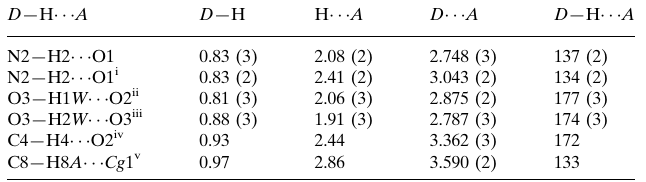
Hydrogen-bond geometry (A˚ , (cid:2)